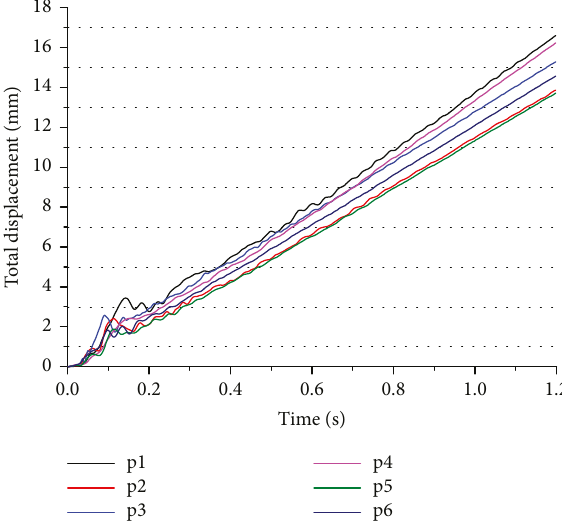
Figure 34: Time-history response curve of resultant displacement at characteristic points on the embankment in the fi rst excavation.